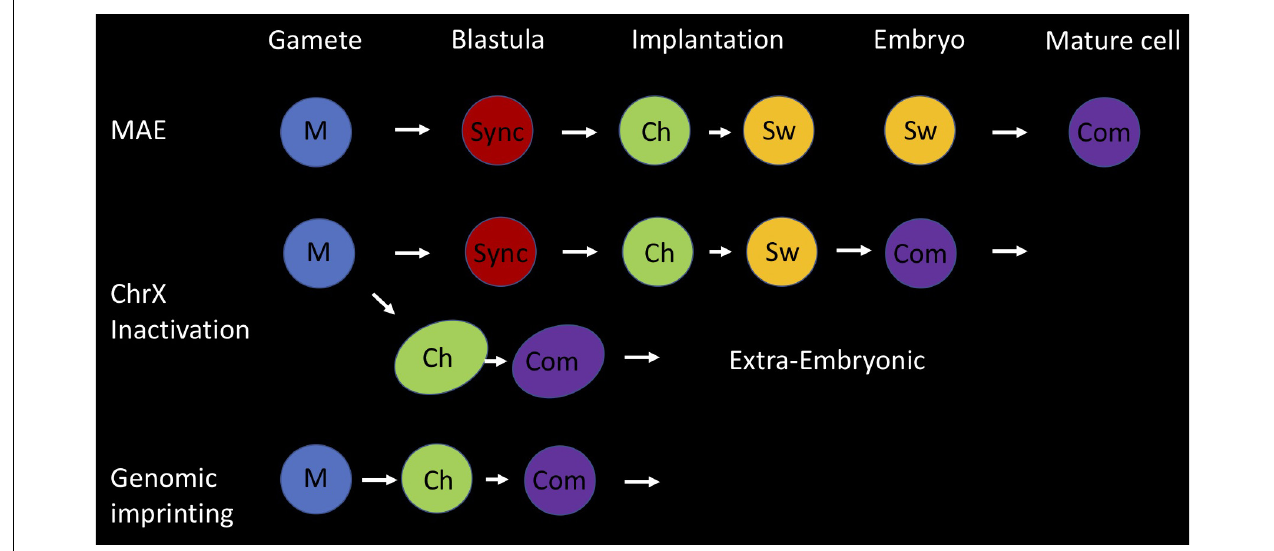
FIGURE 4 | Holistic model for asynchronous replication timing (ASRT). Three different forms of developmentally based monoallelic expression (MAE) are associated with regional asynchronous replication timing; genomic imprinting, inactivation of one X chromosome in female animals and random MAE of autosomal genes. Here we present an integrative developmental model for the establishment of allelic choice with its basic building blocks. This process is accomplished in three seminal steps; marking (M), choice (Ch), and commitment (Com). In all cases, the two alleles are marked (M) differentially in the gametes, where each parental allele is separated from its partner. One is marked as being of maternal origin and the other as being of paternal origin. For random MAE, the two alleles replicate synchronously (sync) in cells of the early pre-implantation embryo. Asynchronous replication is initiated at the stage of implantation, when one allele is chosen (Ch) to replicate early and the other late, based on the epigenetic mark (M) derived from the gametes. In all subsequent replication cycles, the two alleles switch (Sw) their time of replication in S phase, but each locus still retains its parallel or anti-parallel orientation relative to other ASRT loci in the genome. Switching continues in cells of the embryo until they commit (Com) to one fixed parental replication pattern. Imprinted gene regions are initially marked in the gametes, but immediately adopt allele-specific asynchronous replication timing in the early embryo and become committed (Com) to this fixed pattern in all cells, without going through a stage of switching. The inactivation of one copy of ChrX in female embryos utilizes both these pathways. After marking in the gametes, they establish an imprinted pattern of ASRT during formation of the extra-embryonic tissues, while they replicate synchronously in embryonic cells before setting up ASRT at the time of implantation and then undergoing switching to enable random X inactivation and commitment, post